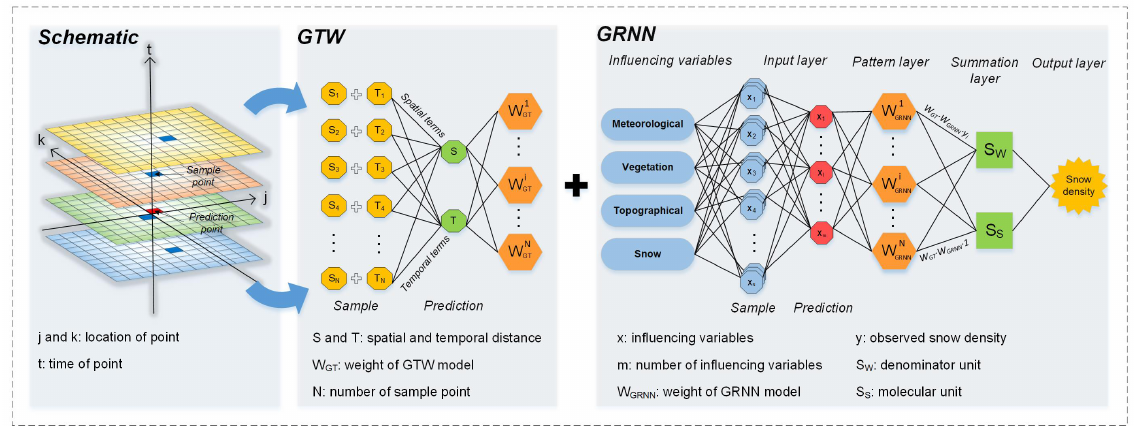
Figure 2. Schematic of the GTWNN model for the estimation of snow density, where GTW refers to the geographically and temporally weighted, and GRNN refers to the generalized regression neural